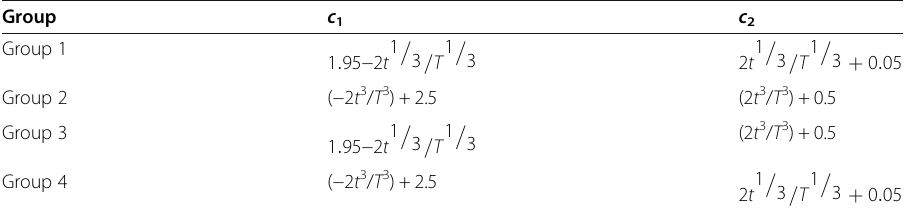
Table 4 AGPSO coefficients updating strategies Group c 1